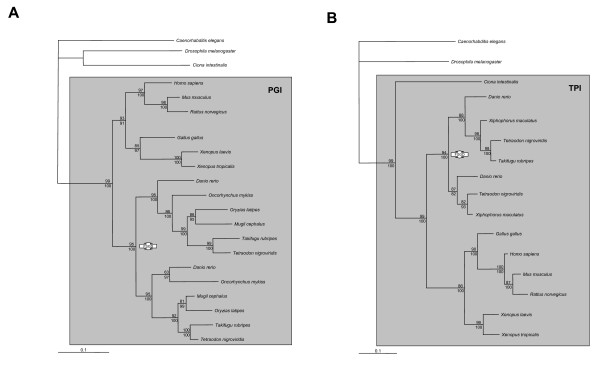
Maximum-likelihood tree of the homodimeric composing glycolytic enzymes phosphoglucose isomerase (PGI), and triosephosphate isomerase (TPI) dataset comprising 22 amino-acid sequences for PGI (555 AA), and 16 amino-acid sequences for TPI (250 AA). Values at the branches are support values (ML bootstrapping/MB posterior probabilities). 'FSGD' depicts putative fish-specific gene duplication events.